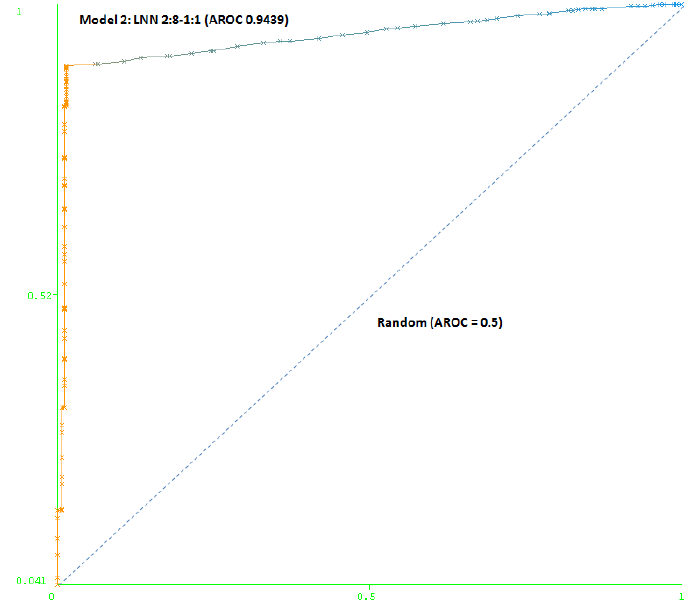
Figure 4. Area under the receiver operating characteristic curve (AUC-ROC) for LNN 2:8- 1:1 (Model